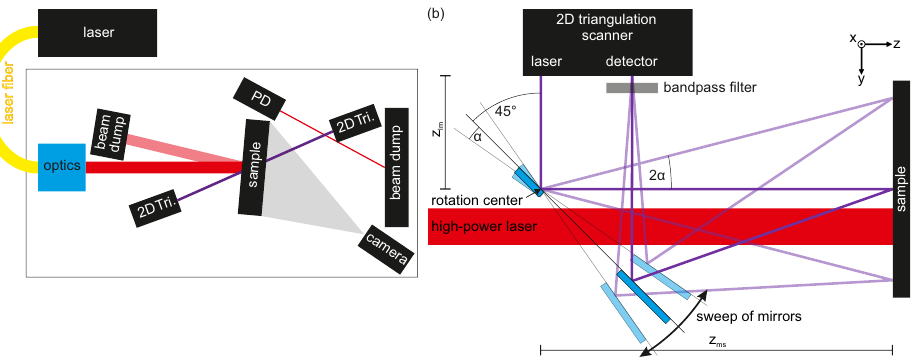
Figure 1. Illustration of the experimental setups: ( a ) the complete setup with the bidirectional triangulation measurement and ( b ) specific scanning 3D triangulation setup. In the latter, the measurement laser light was deflected by mirrors (light blue), which were rotated around a common axis, allowing to scan the sample surface perpendicular to the 2D triangulation